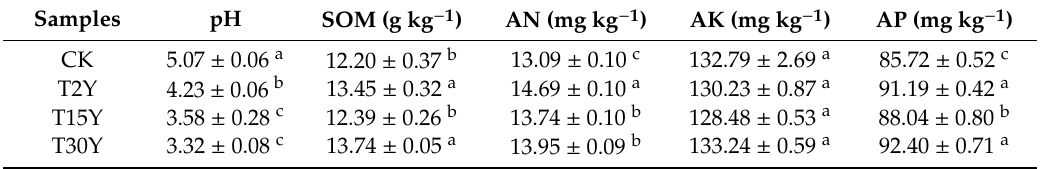
Table 2. Physiochemical characteristics of soil under continuous tea